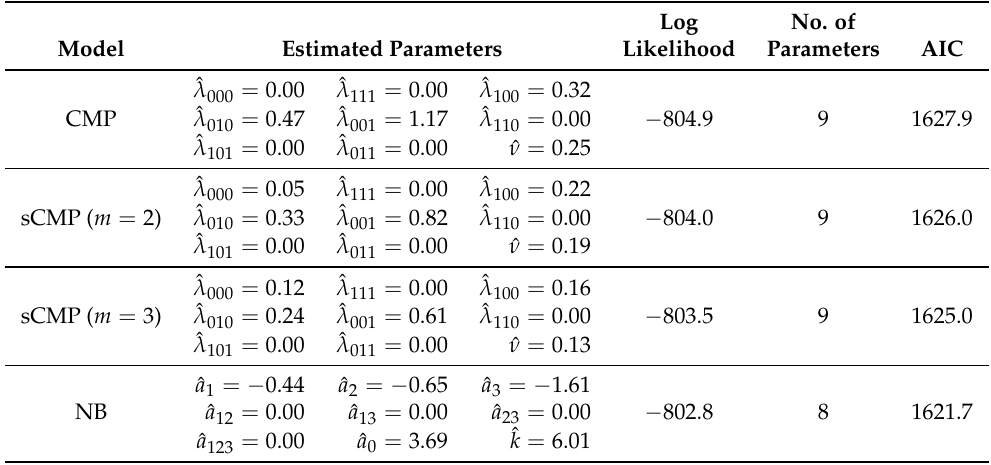
Table A1. Estimation results associated with the Corporación Favorita grocery sales data based on various assumed trivariate models: CMP, sCMP ( m = 2), sCMP ( m = 3), and NB. Respective log-likelihood and Akaike Information Criterion (AIC) values are also provided.